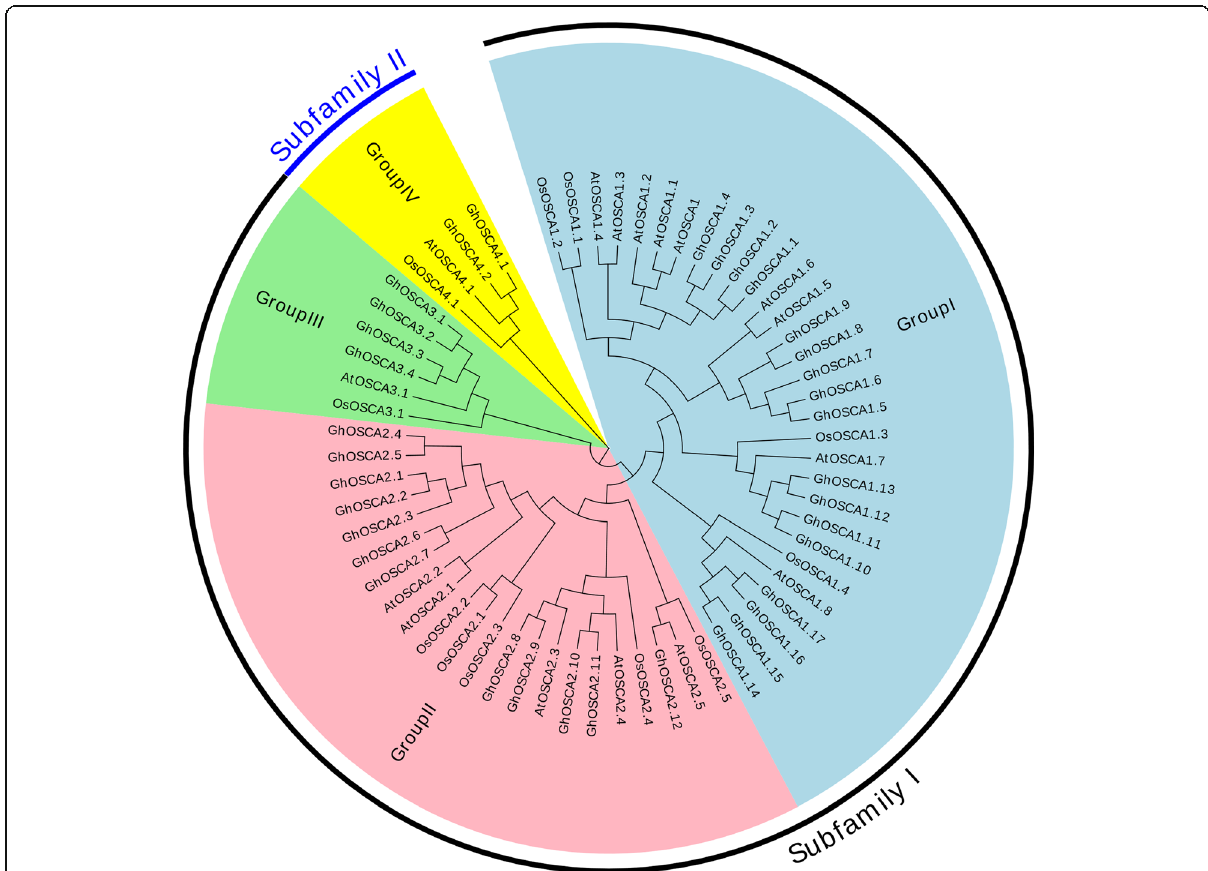
Fig. 1 Phylogenetic analysis of OSCA protein in upland cotton, Arabidopsis and